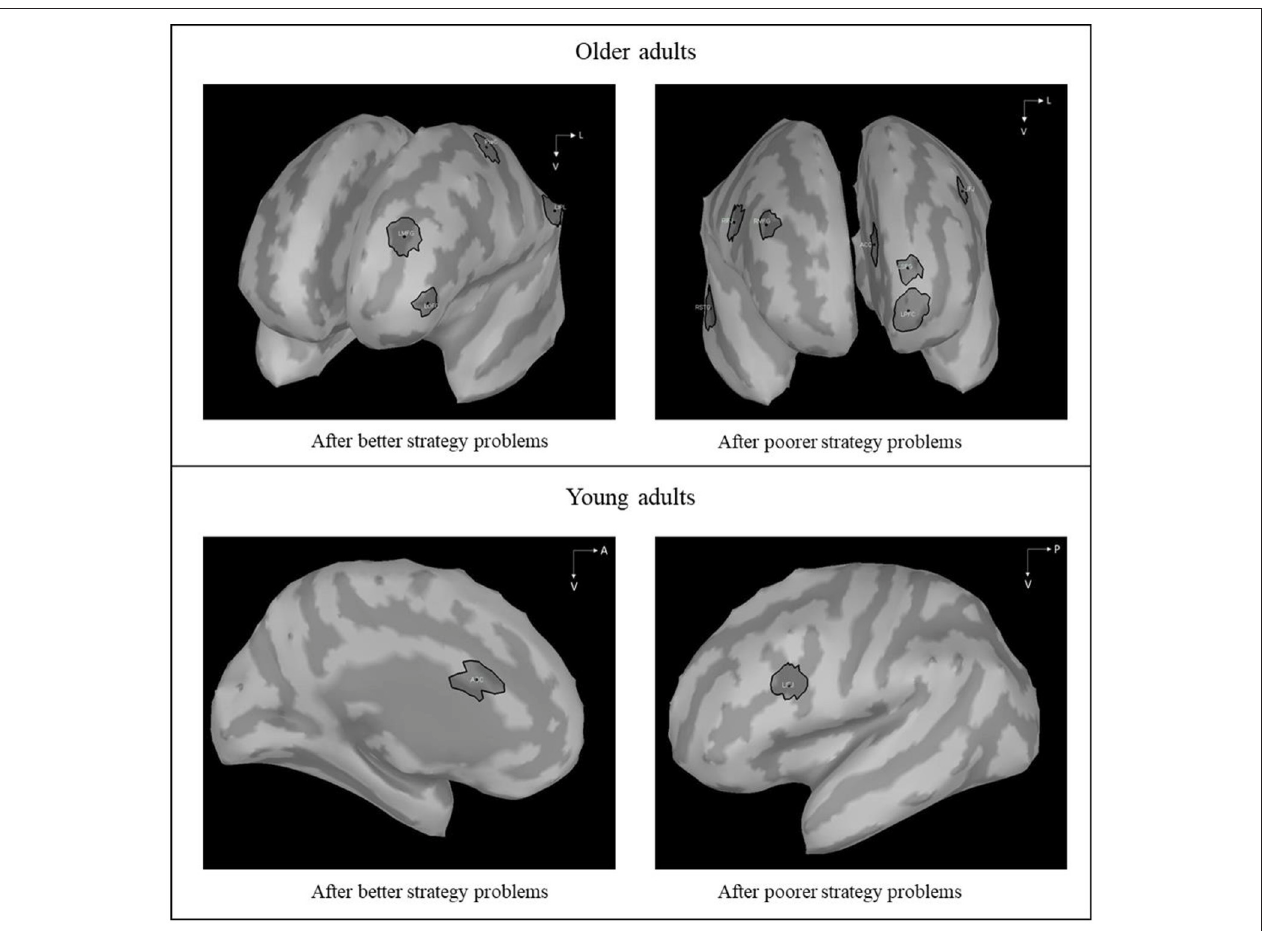
FIGURE 3 | Differences in z-scored amplitudes, on current poorer strategy problems, between previous better strategy problems and following previous poorer strategy problems in older adults comparatively in young adults (Hinault et al., 2017). In older adults, when the second problems were preceded by the execution of the poorer strategy, significant brain activations were found in ACC (Anterior Cingulate Cortex), LIFJ (Left Inferior Frontal Junction), RIFJ (Right Inferior Frontal Junction), RPFC (Right Prefrontal Cortex), LMFG (Left Median Frontal Gyrus), RSFG (Right Superior Frontal Gyrus), LSFG (Left Superior Frontal Gyrus), and RSTG (Right Superior Temporal Gyrus) between − 400 and − 200ms before the second problems display and between 500 and 650ms following the onset of the second problems. When the second problems were preceded by the execution of the better strategy, activations were found in LMFG (Left Middle Frontal Gyrus), LPreCG (Left Precentral Gyrus), LOFC (Left Orbitofrontal Cortex), and LIPL (Left Inferior Parietal Lobule) between 100 and 350ms and between 850 and